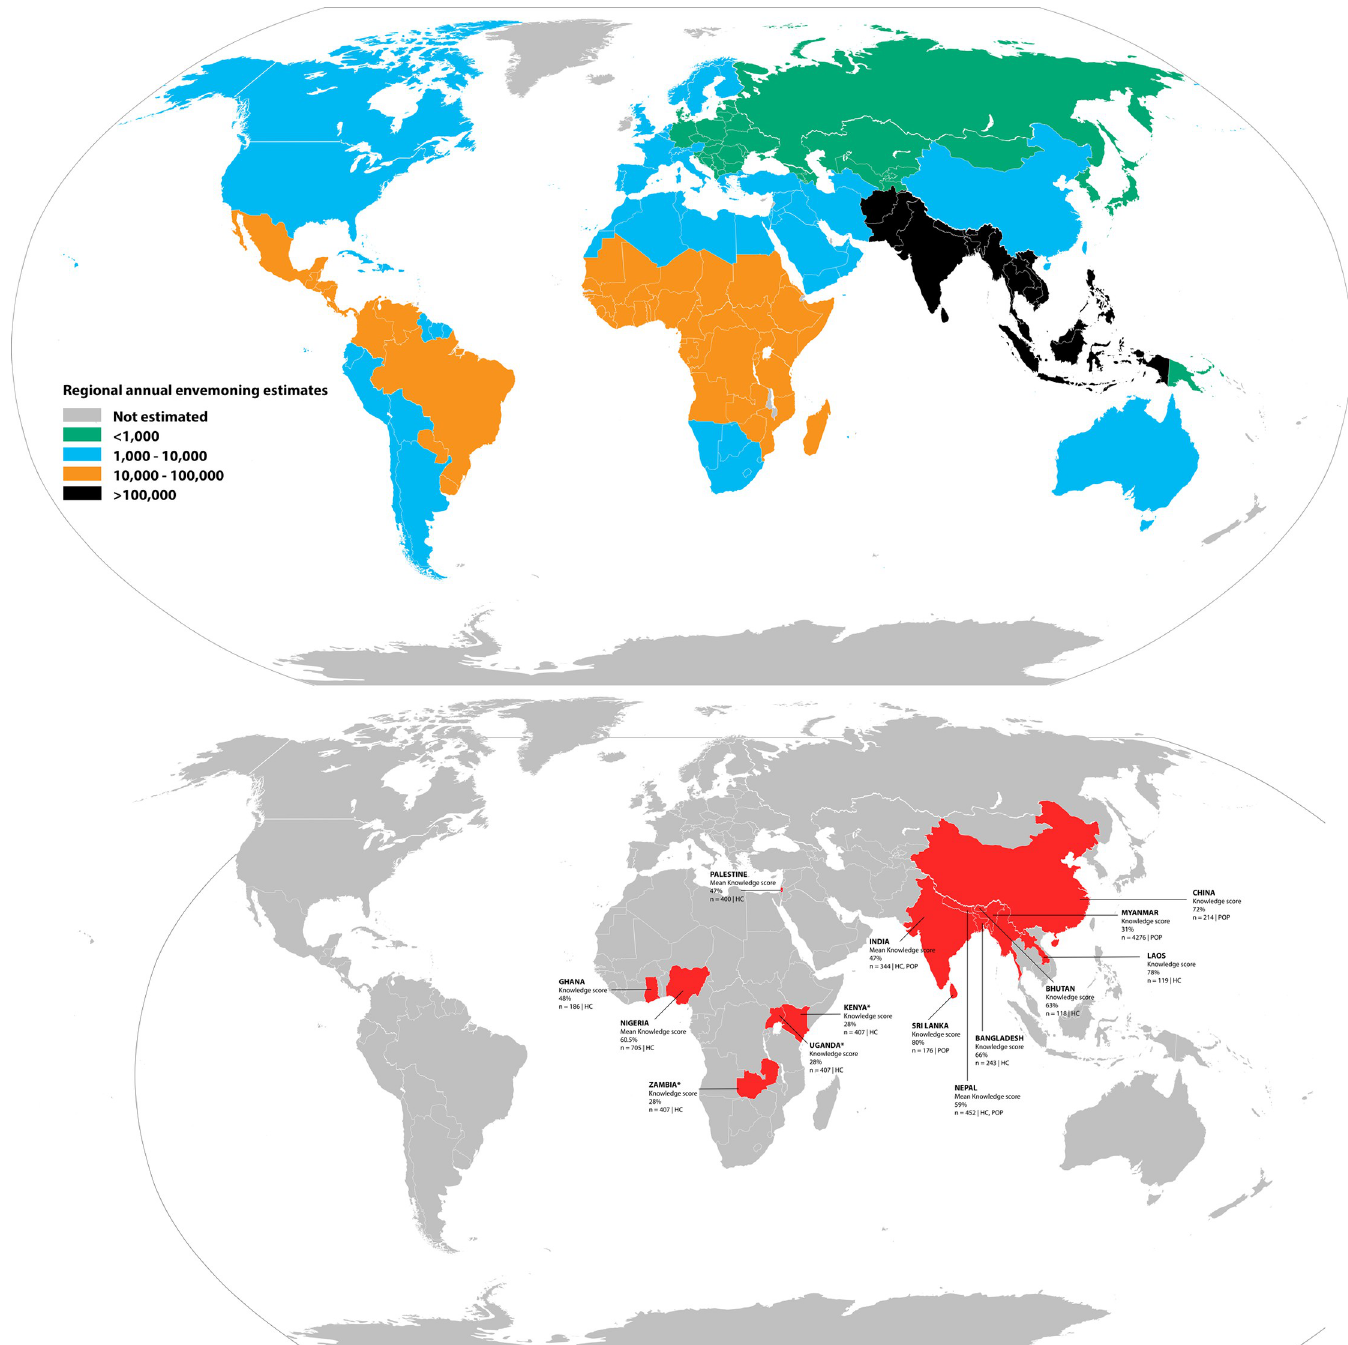
Fig 2. (2A) World map with annual envenoming estimates across the globe vs. (2B) countries with studies included in the current review. Knowledge scores, study populations, and sample size have been provided. For countries with multiple studies, mean knowledge scores have been provided and noted. Study populations include HC = Health Care Workers (clinicians, nurses, medical students, etc.) and POP = General population (the direct link to the base layer of the map: https://commons. wikimedia.org/wiki/File:BlankMap-World.svg).